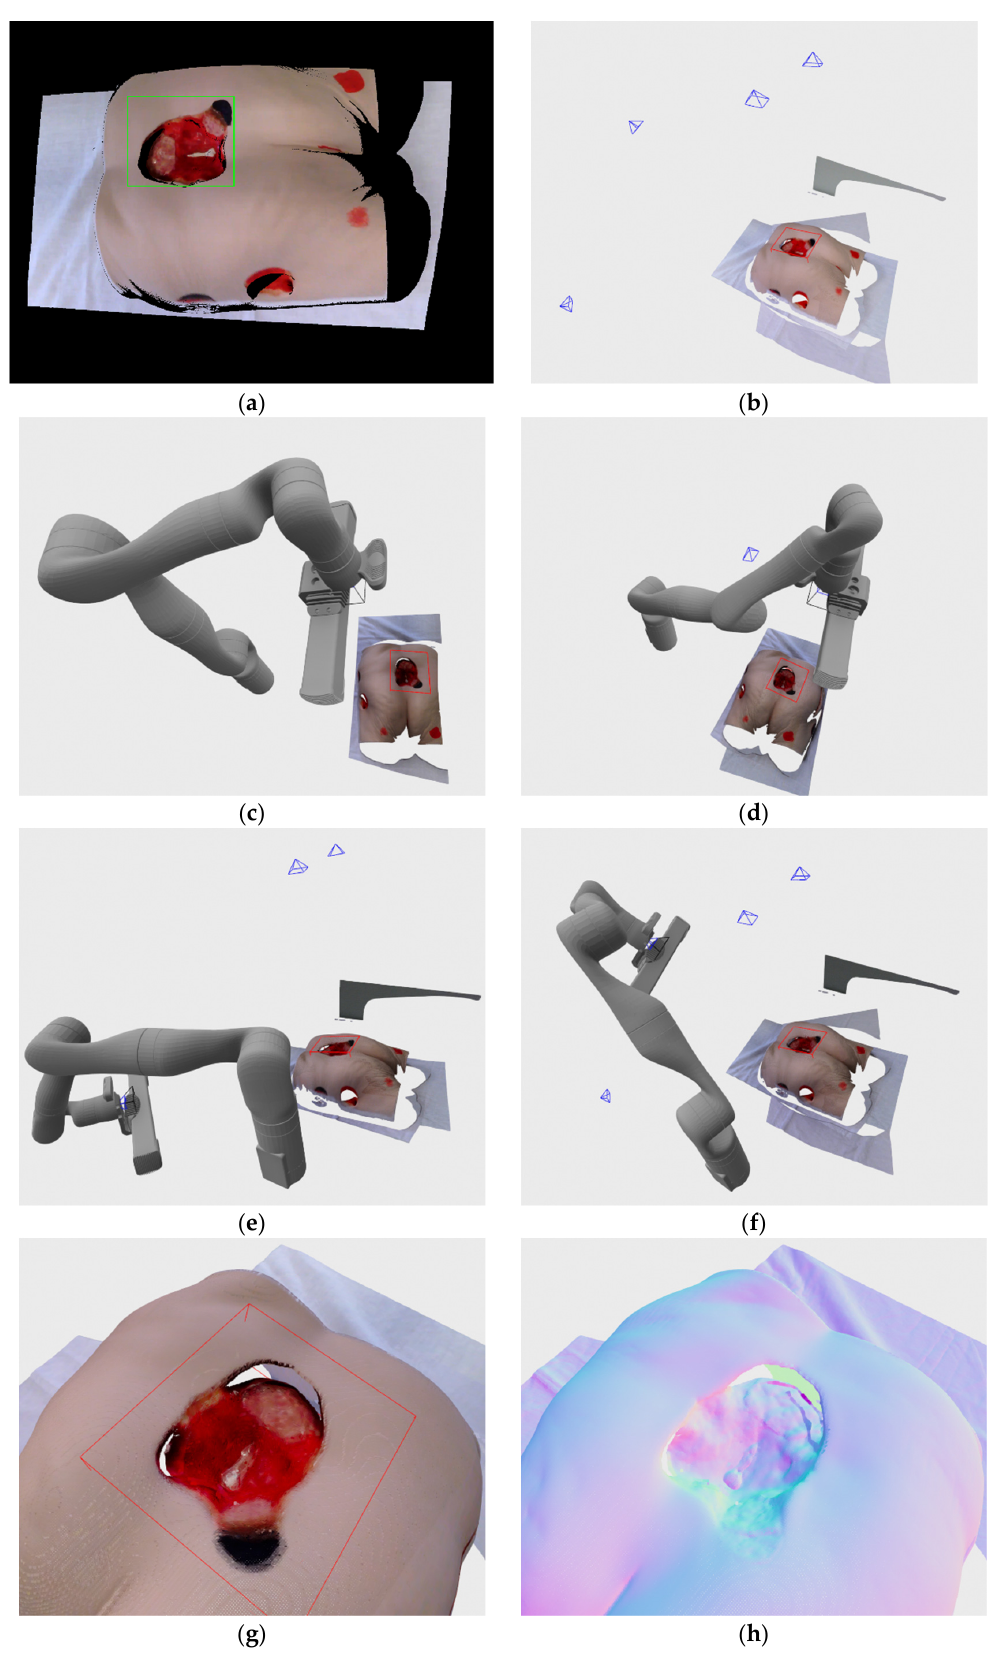
Figure 16. Recording of stage IV pressure ulcer medical wound model: ( a ) wound detection at initial recording position; ( b ) recording poses relative to the recorded wound; ( c ) robot position in relation to the recorded wound in first